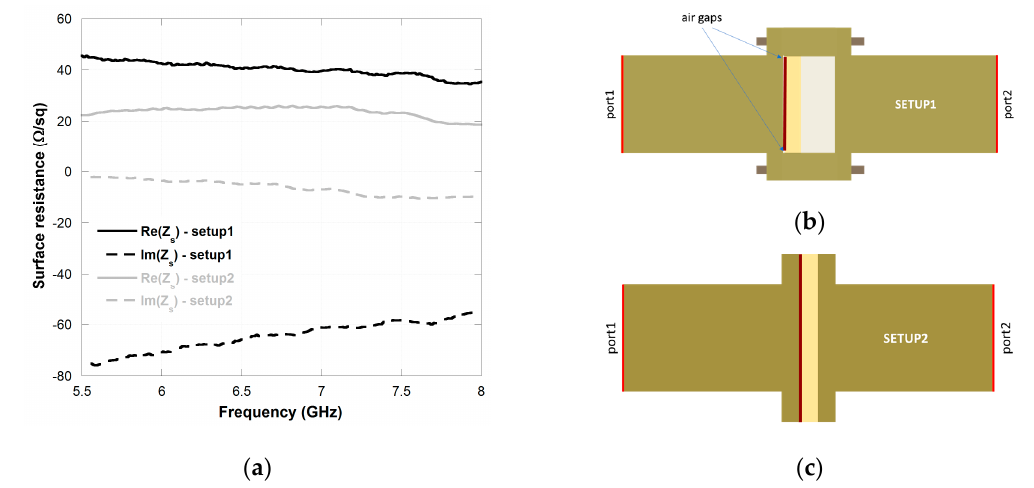
Figure 18. Estimated surface resistance of an ink deposition with a DC surface resistance of 20 ohm/sq ( a ). The substrate is FR4 with a thickness of 1.6 mm. The results are obtained by using setup 1 ( b ) and setup 2 ( c ).